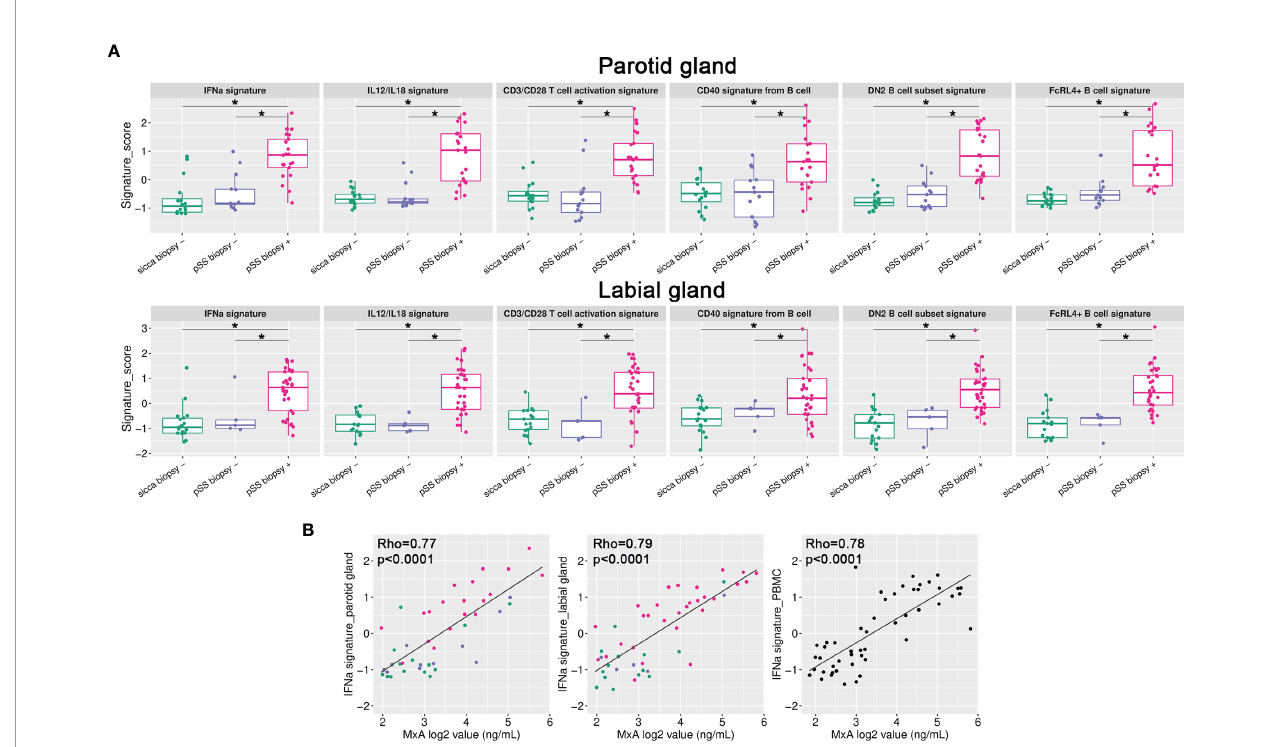
FIGURE 3 | Gene signature analysis of paired salivary gland tissue samples. (A) Gene signature scores were calculated for all individual samples and plotted per signature per group for either the parotid or labial gland. *p < 0.005 (B) IFN- a signature scores in parotid and labial gland tissue and PBMCs were correlated with blood MxA levels. Colors represent the different patient groups as indicated in Figure 1